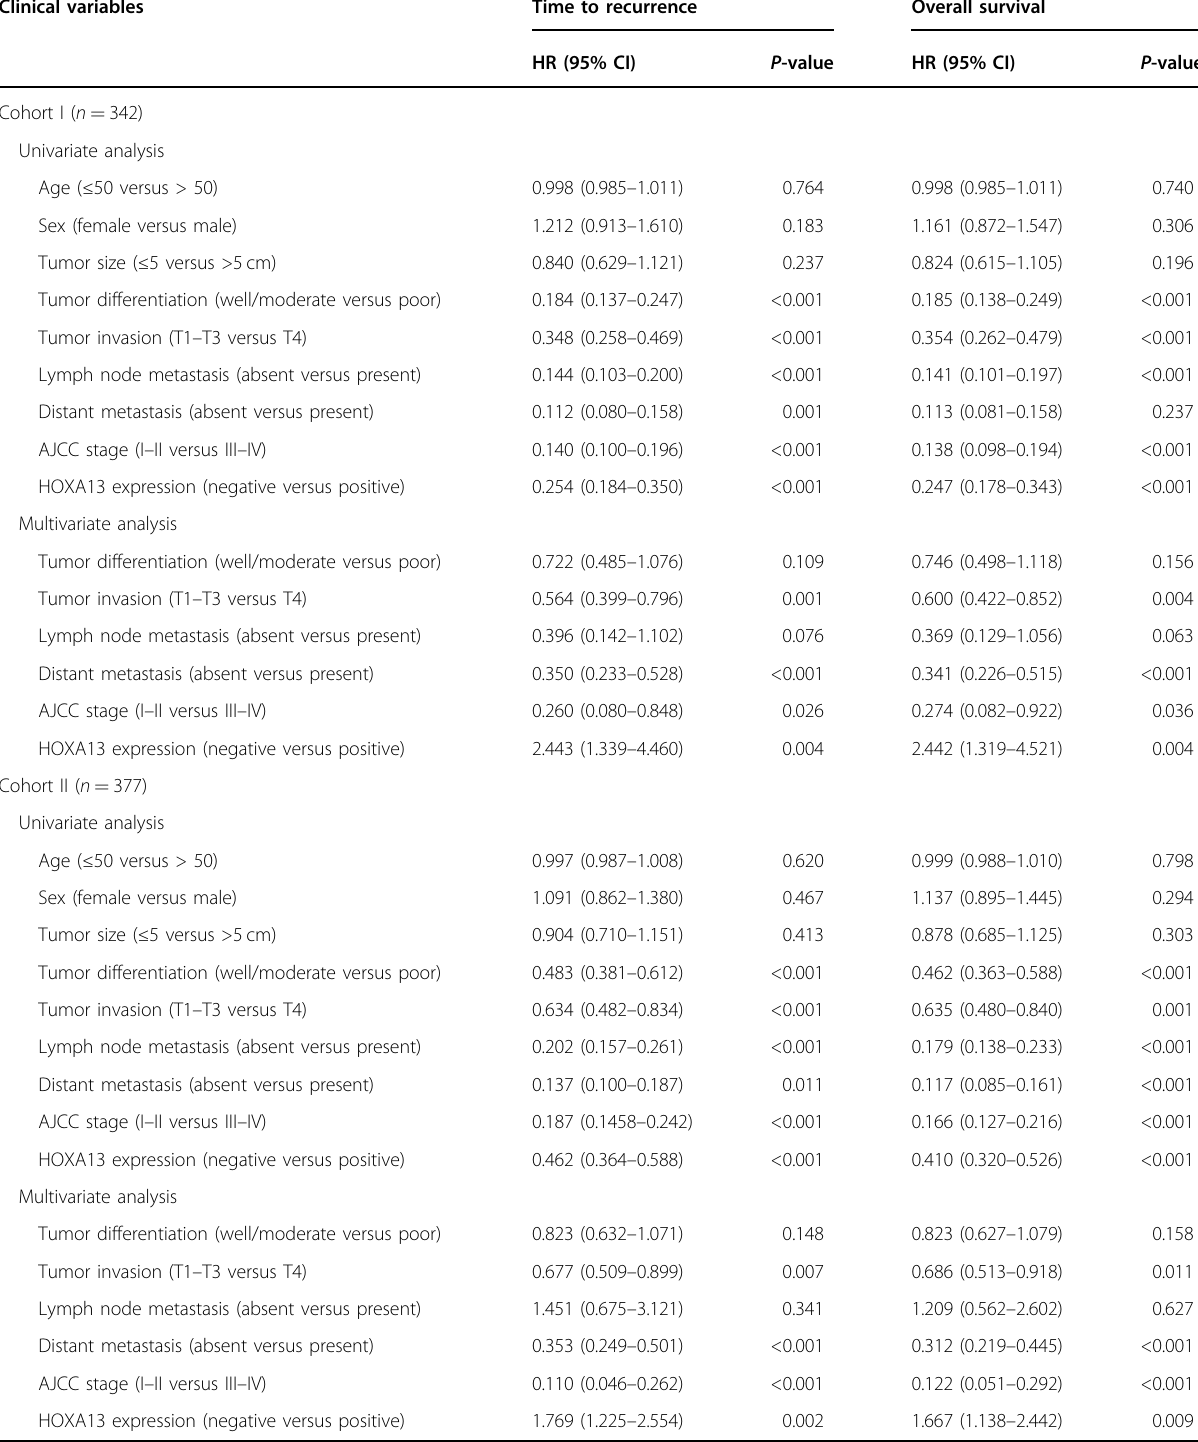
Table 2 Univariate and multivariate analysis of factors associated with survival and recurrence in two independent cohorts of human